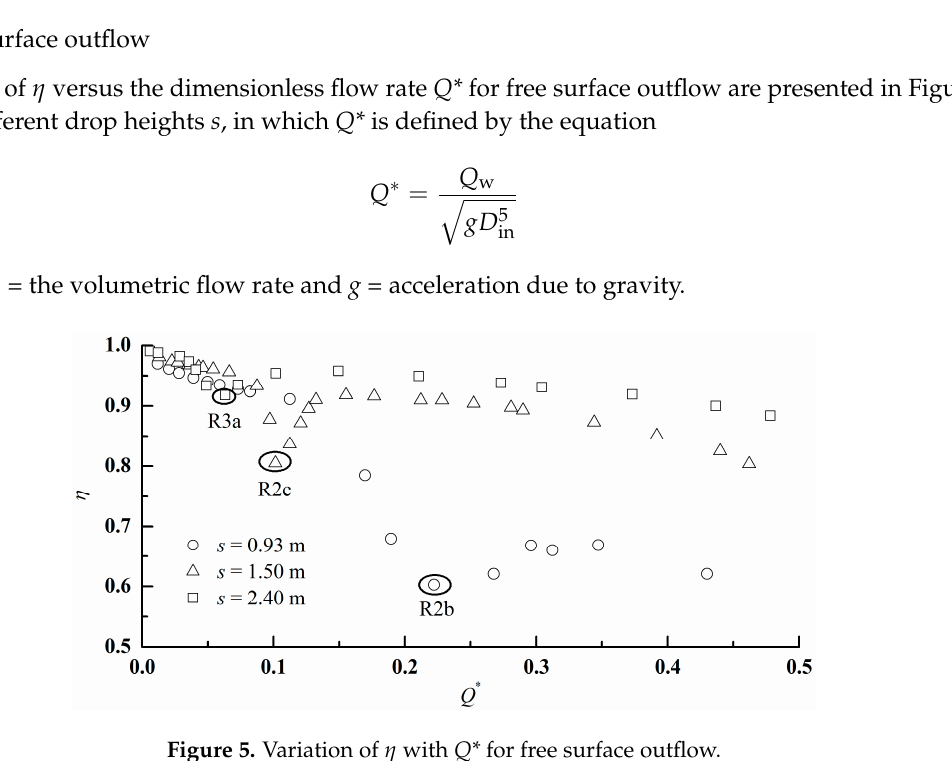
Figure 5. Variation of η with Q* for free surface outflow.